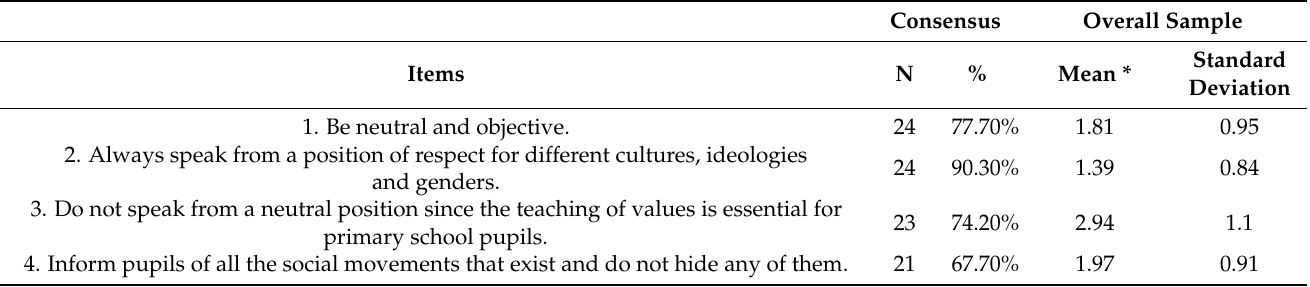
Table 4. Third round. Category C. Ethical implications for primary schoolteachers when discussing social